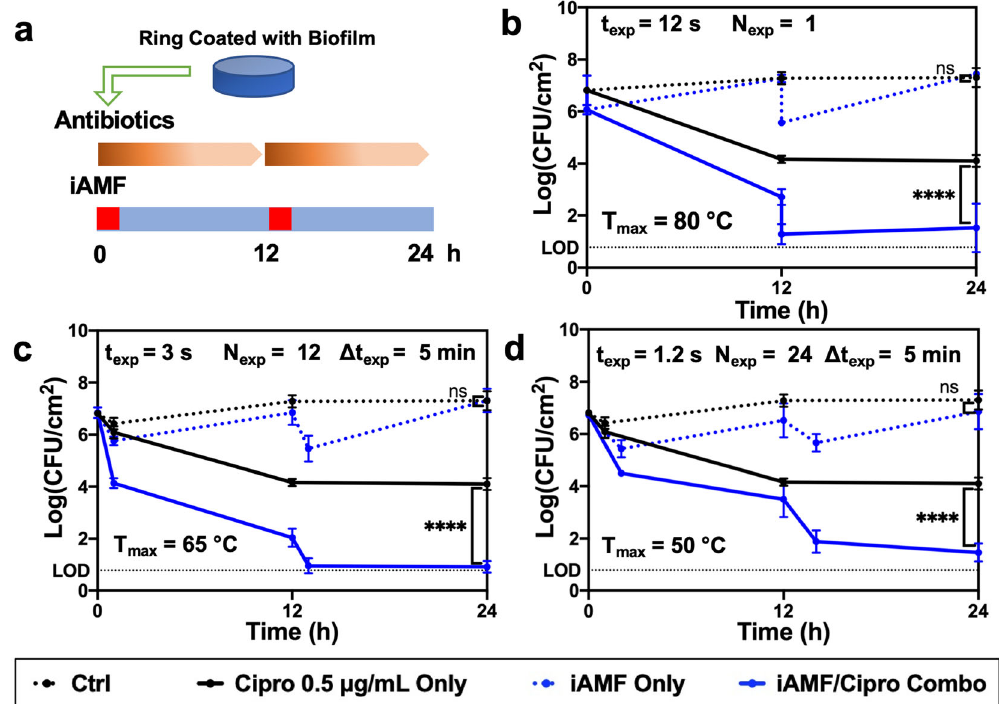
Fig. 2 iAMF and cipro fl oxacin are synergistic in reducing P. aeruginosa bio fi lm. a The general treatment scheme for combining iAMF and antibiotics. b – d Bacterial log reduction over a 24-h period for PAO1 bio fi lm upon treatment with iAMF heating alone (blue dotted line), cipro fl oxacin at 0.5 μ g mL − 1 alone (black solid line) or iAMF + cipro fl oxacin (blue solid line) at different peak temperatures T max of b 80 °C, c 65 °C, or d 50 °C. The number of exposures was varied for each case as shown in the panels. Untreated controls (black dotted line) were not exposed to antibiotics or AMF. Colony-forming units (CFU) were counted at 0, 12 h (pre- and post-AMF), and 24 h post treatment. n = 3. Error bars indicate SD. CFU limit of detection (LOD) = 0.78 log(CFU cm − 2 ). Two-way ANOVA. Signi fi cance: not signi fi cant (ns) and signi fi cance at p < 0.0001